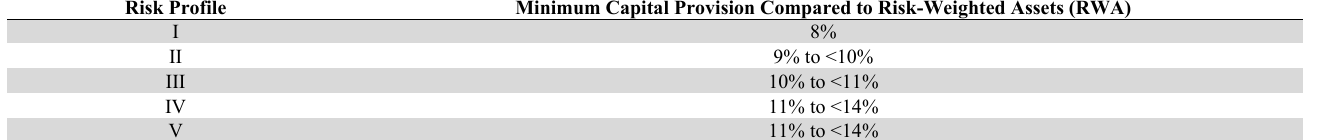
Level of Minimum Capital Provision Compared to Risk-Weighted Assets (RWA) Risk